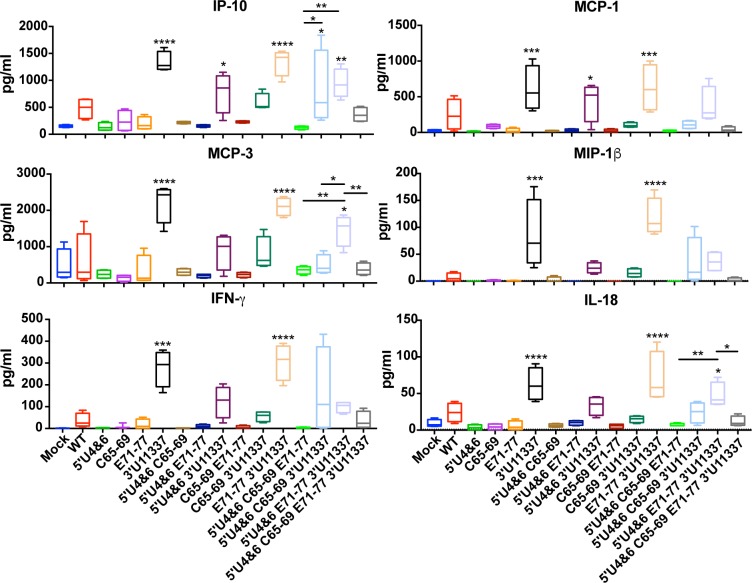
LAVs competent for myeloid cell replication induce greater systemic cytokine responses.CD-1 mice were infected with equal genomes of the indicated LAV and at 24 hours post infection, serum was collected for Luminex analysis. Asterisks above each box and whisker plots indicate significant difference compared to mock. Bars indicate significant differences between triple and quadruple mutant LAVs only. *P<0.05, **P<0.01, ***P<0.001, ****P<0.0001, by one-way analysis of variance with Turkey’s multiple-comparison test. N = 4 mice.